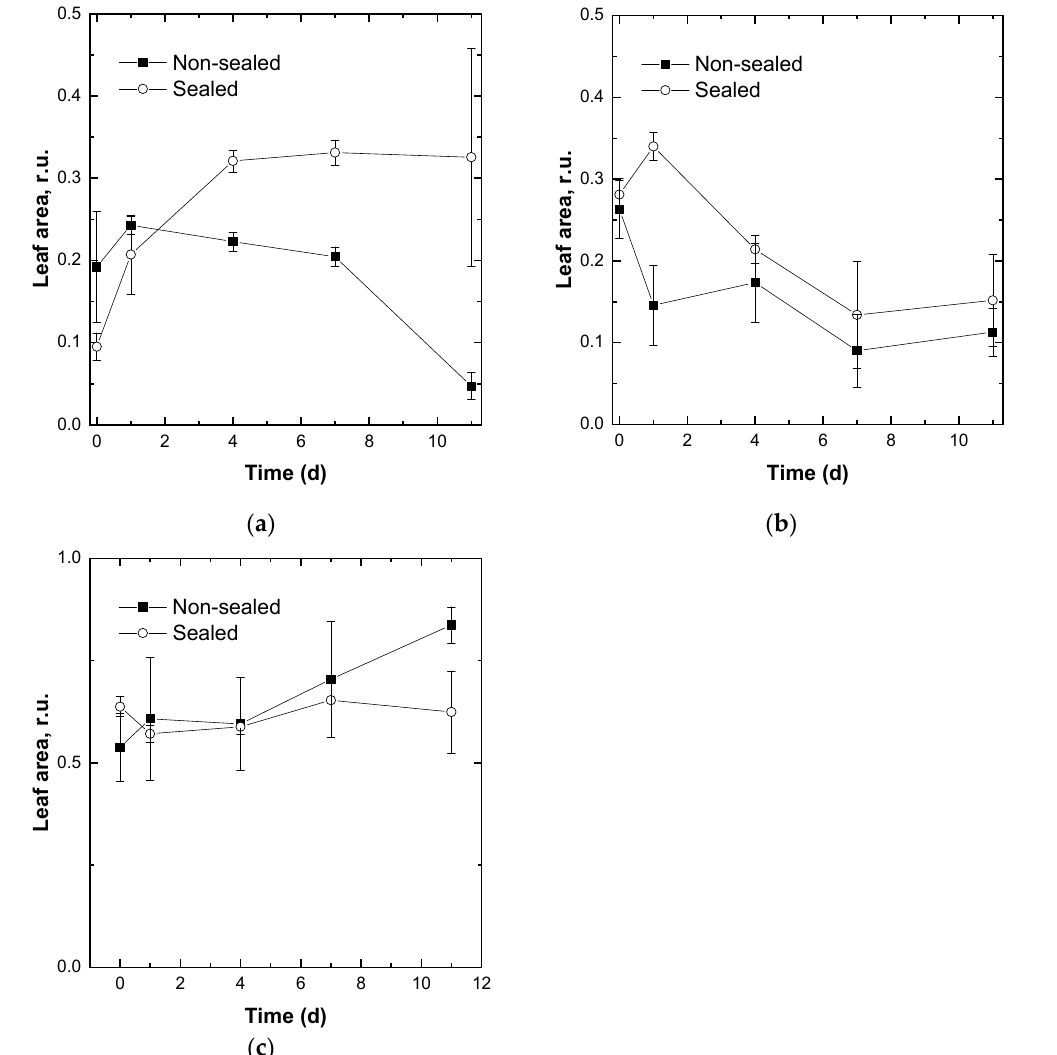
Figure 5. Changes in the relative area of the stored non-sealed (closed symbols) and sealed (open symbols) fresh-cut lettuce leaves possessing PS II Qy values in the range ( a ) 0.4–0.6, ( b ) 0.6–0.7, and ( c ) 0.7–0.8. Average ± SE values are presented ( n = 9). For details, see Materials and Methods.